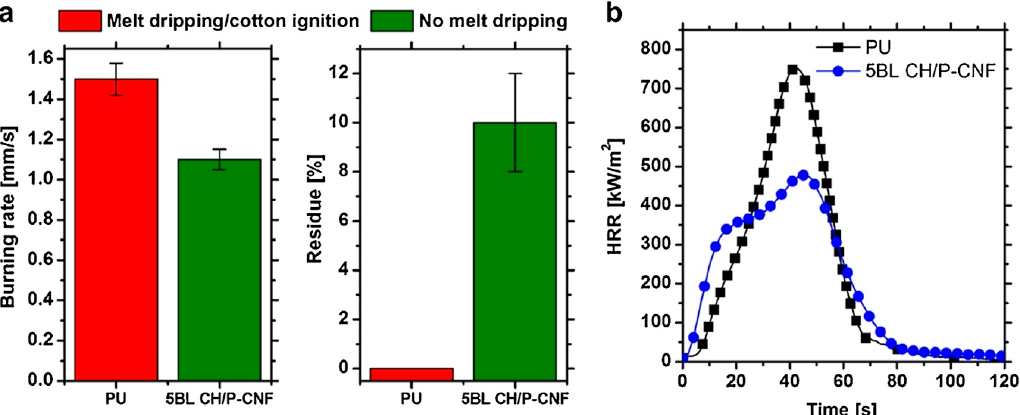
Figure 28. Burning rates and final residues evaluated by flame spread tests performed in horizontal configuration ( a ) and Heat Release Rate (HRR) plots as a function of time measured by cone calorimetry tests ( b ). PU: untreated polyurethane foam; 5 BL CH/P-CNF: foam treated with 5 bi-layers of chitosan and phosphorylated cellulose nanofibrils. Reprinted with permission from [55]. Copyright 2018, Elsevier.